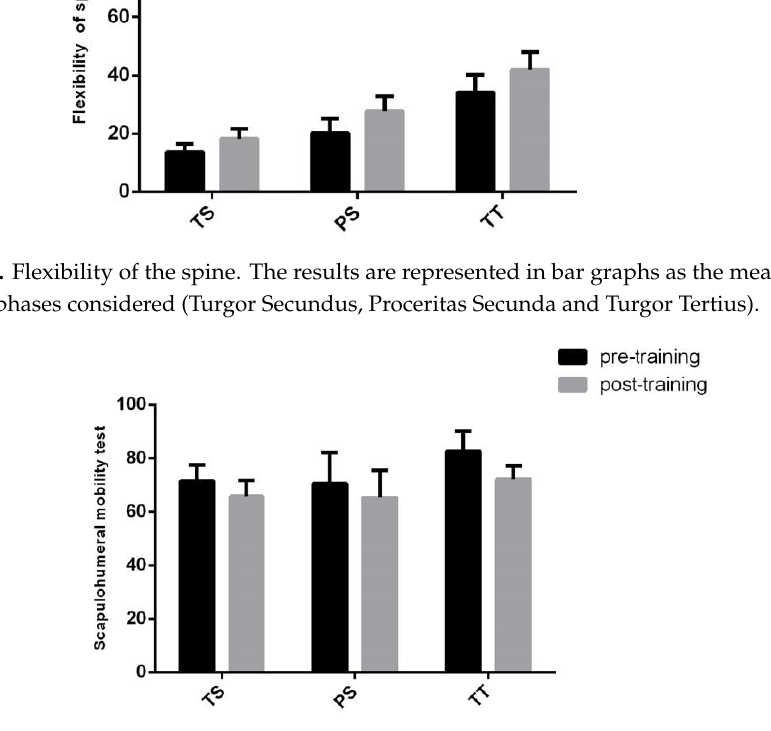
Figure 11. Scapulo–humeral mobility test. The results are represented in bar graphs as the mean ± SD of the different phases considered (Turgor Secundus, Proceritas Secunda and Turgor Tertius).